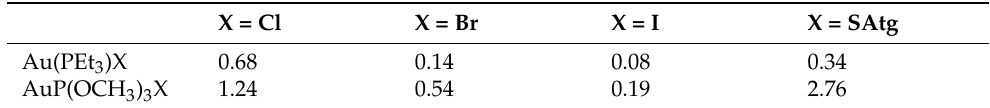
Table 1. Water solubility of the synthesized compounds in comparison with their parent triethylphos- phine derivatives. Data are given as millimolar